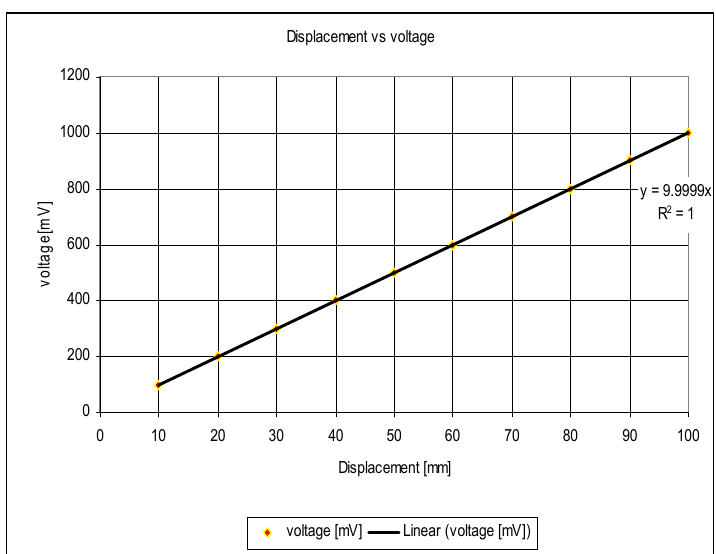
Figure 8. Basic sub-meter-to-voltage